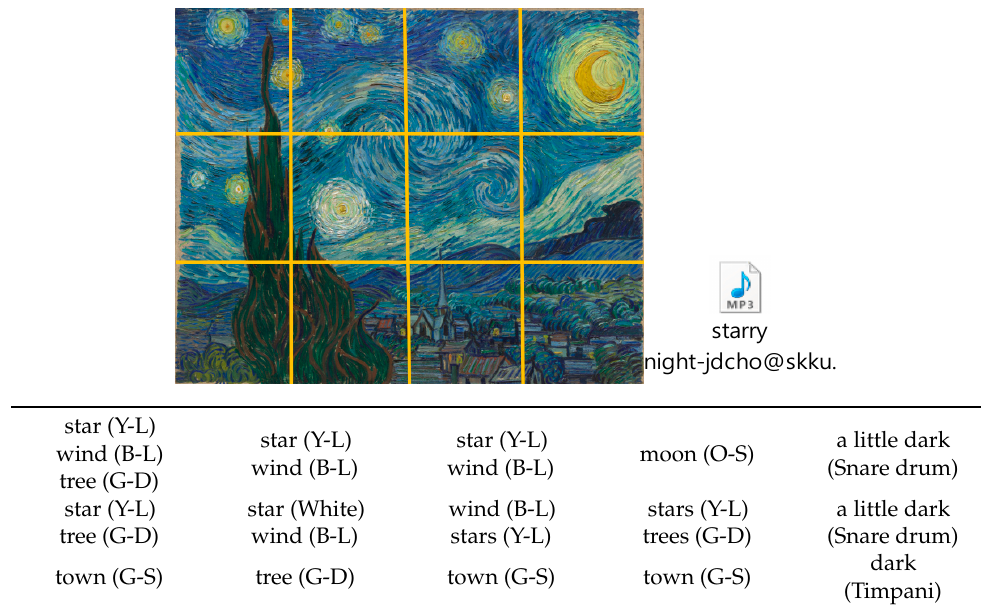
Table 3. Color map table and single music coding colors in Van Gogh’s “The starry night” (the sound files developed in this research are provided separately as a Supplemental Material).